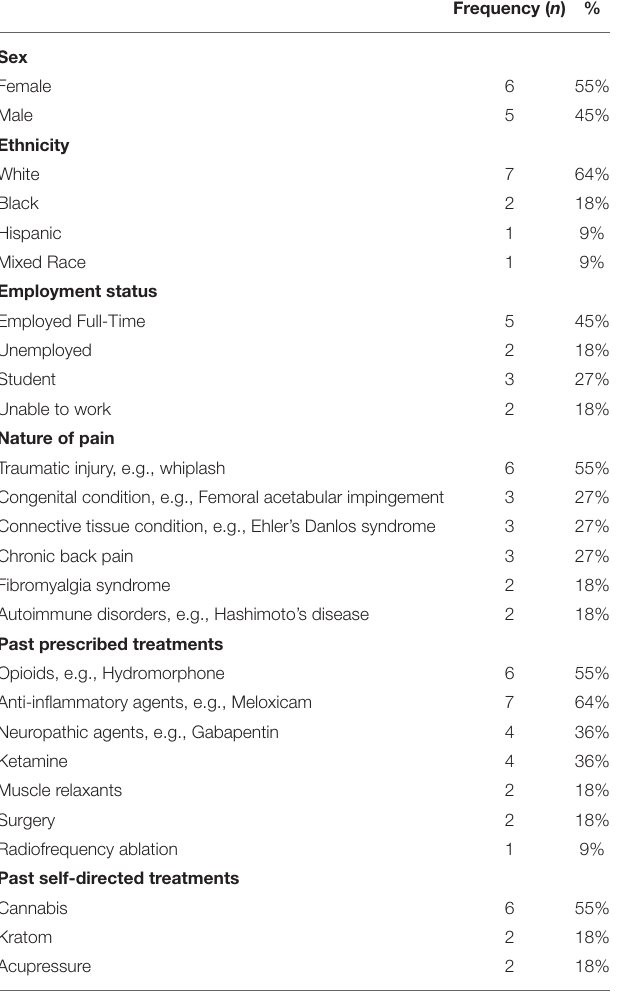
TABLE 1 | Summary of contributor demographics. TABLE 2 | Summary of substances, dose, supplementary treatments, and pain